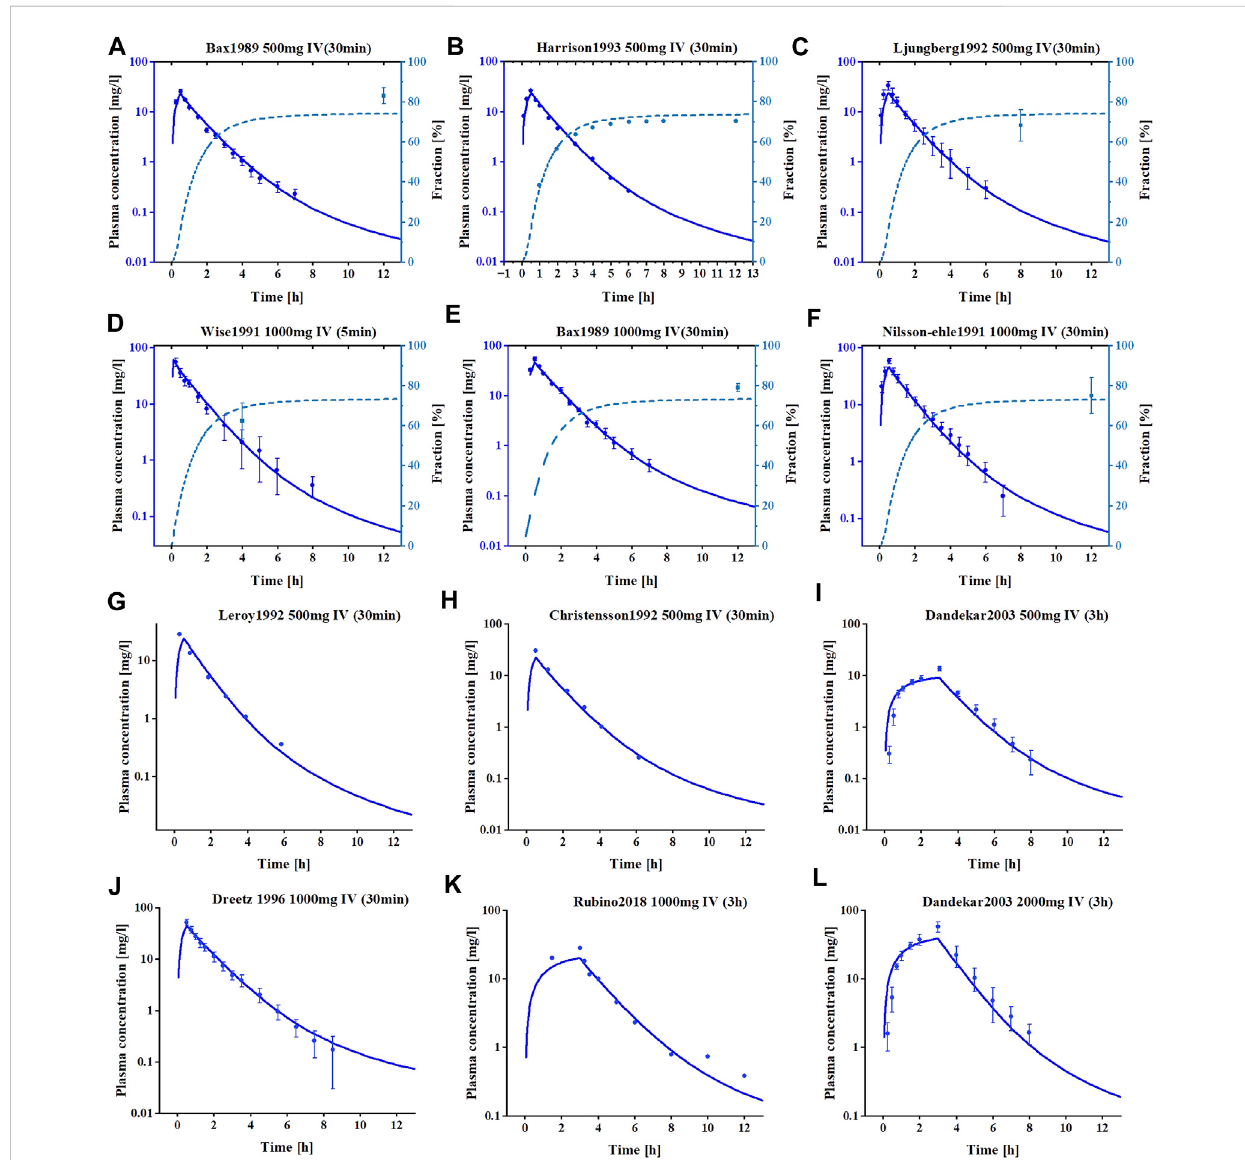
FIGURE 1 Thesimulatedandobservedplasmaconcentration-timepro fi lesofmeropenemPBPKmodelinhealthyadults. (A – F) Aretheplasmaconcentration- time pro fi les for the training datasets. (G – L) are the plasma concentration-time pro fi les for the test datasets. Clinical observed data are shown as mean values (circles), if available ±standard deviation (SD). Solid dark blue lines illustrate the predicted plasma concentrations, dashed light blue lines illustrate the predicted fractions excreted to